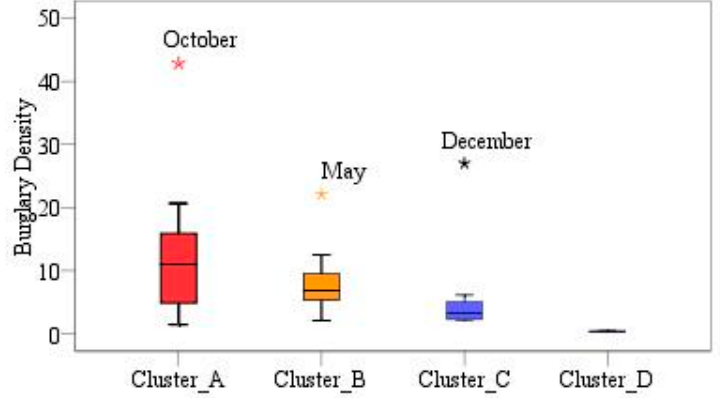
Figure 8. The boxplot for monthly burglary densities in the four-cluster STICA